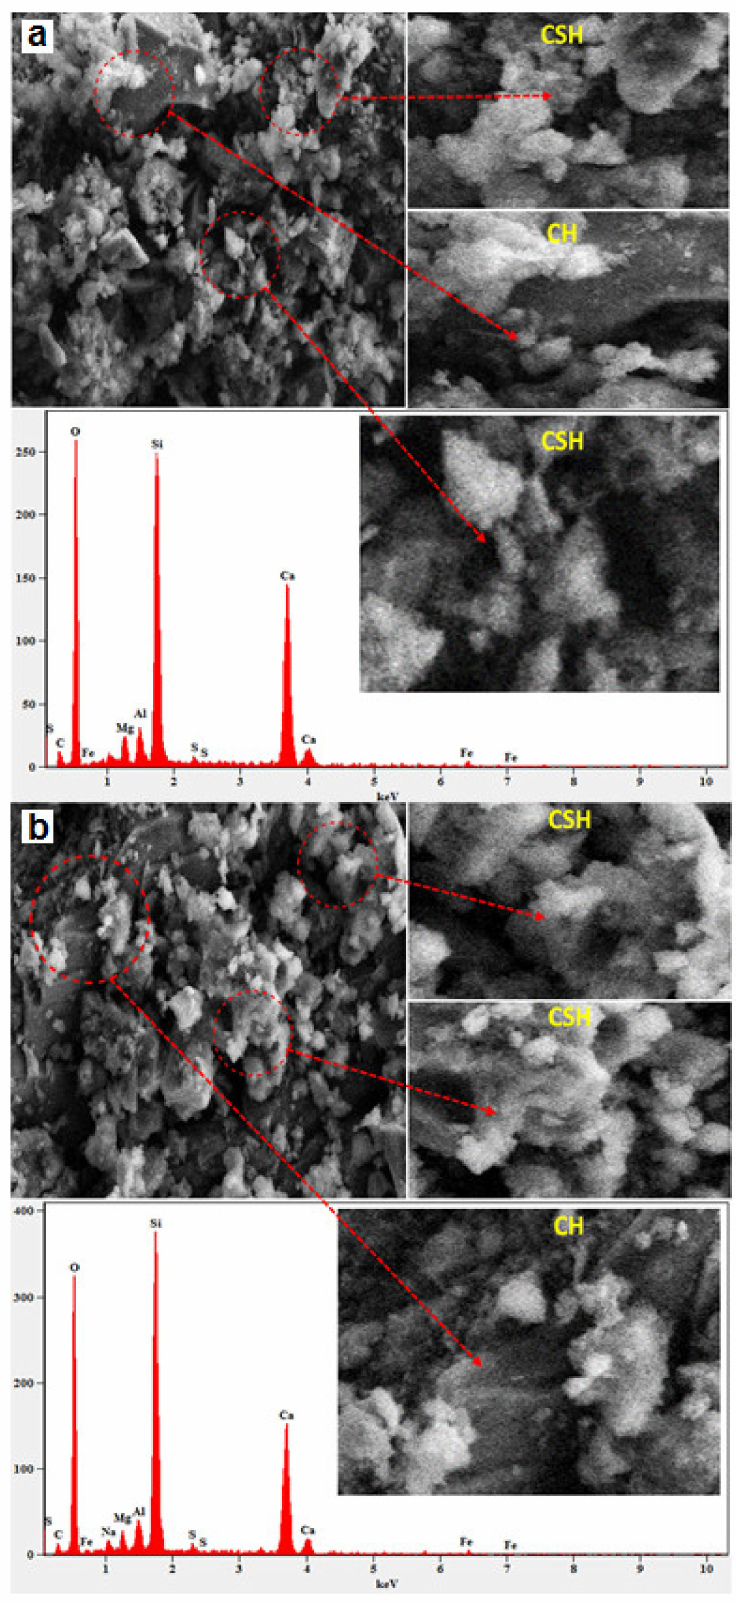
Figure 13. SEM and EDX result of LSF mortar. ( a ) 7 days and ( b ) 28